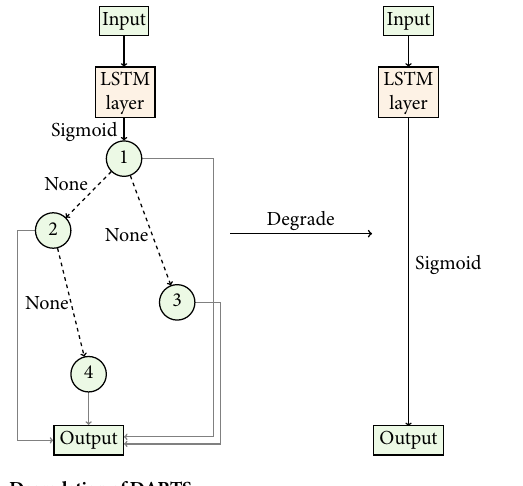
Fig. 6 Degradation of DARTS.